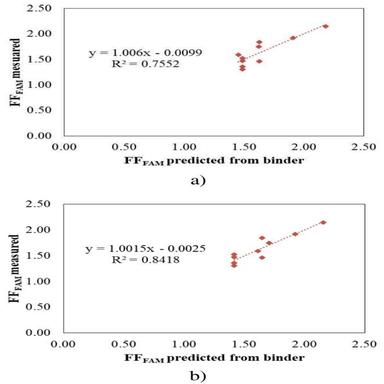
Relationship between the FFFAM measured and predicted from a power law equation considering a) two binder variables, and b) three binder variables.